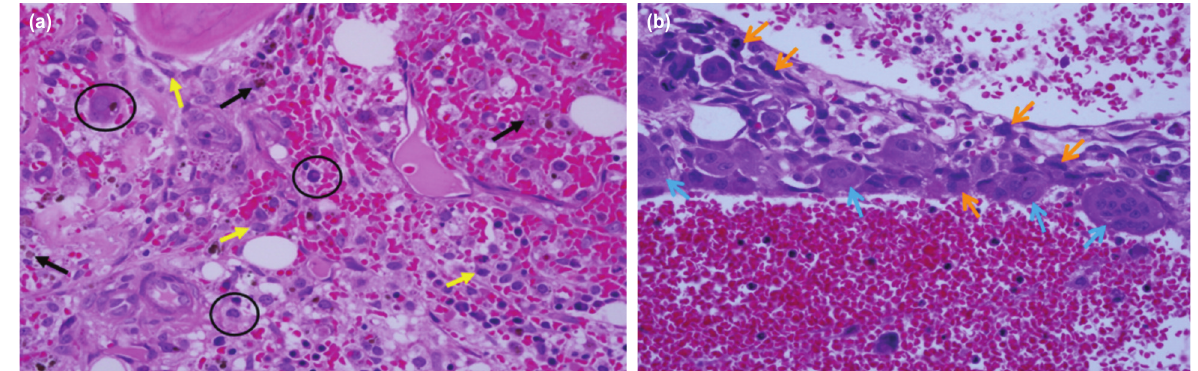
(a) Histopathological assessment of core needle biopsy revealed cystic spaces contain blood with the presence of macrophages Fig. 2: (O), hemosiderin laden macrophages ( ) and reactive fibroblasts ( ), but no any atypical sarcomatous cell was seen. (Haematoxylin and eosin, x40). (b) Histopathological assessment from left hemipelvectomy amputated part showed septum which is lined by atypical sarcomatous cells ( ) admixed with multinucleated giant cells ( ) and cystic space containing blood (Haematoxylin and eosin, x